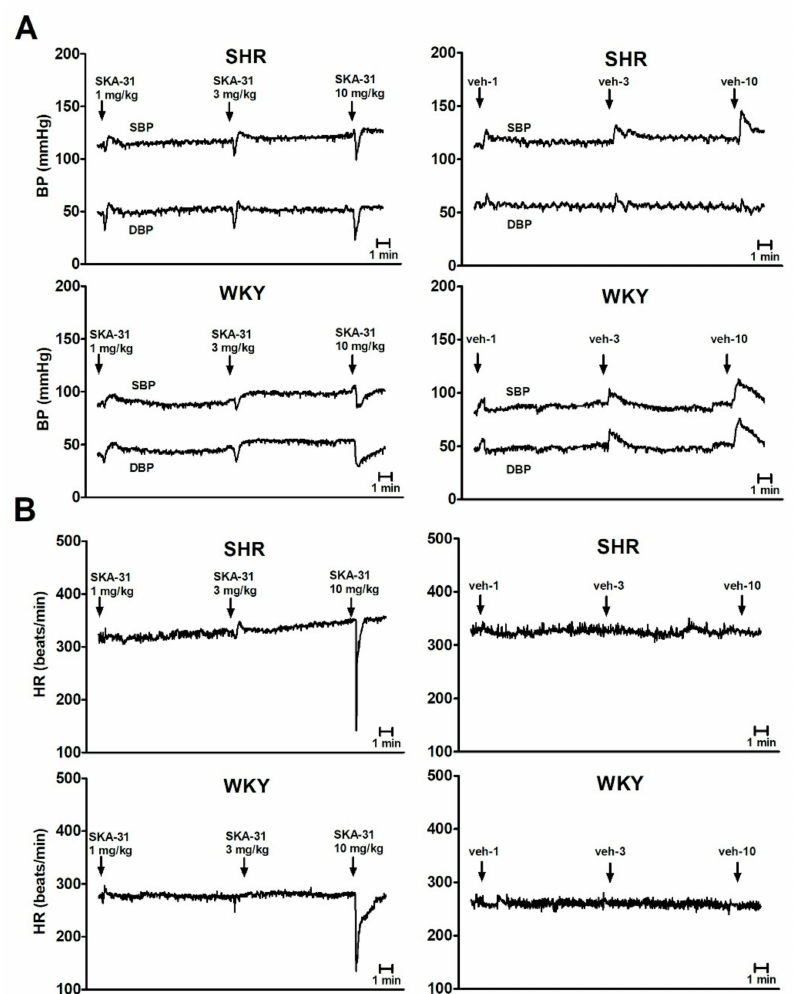
Figure 2. Traces from representative experiments showing the influence of SKA-31 (1, 3, or 10 mg / kg i.v.) or its vehicle (veh-1, veh-3, or veh-10, respectively) on ( A ) diastolic blood pressure (DBP) and systolic blood pressure (SBP) or ( B ) heart rate (HR) in urethane-anaesthetized spontaneously hypertensive rats (SHR) and Wistar Kyoto rats (WKY). Arrows show the moment of injection of the of SKA-31 /